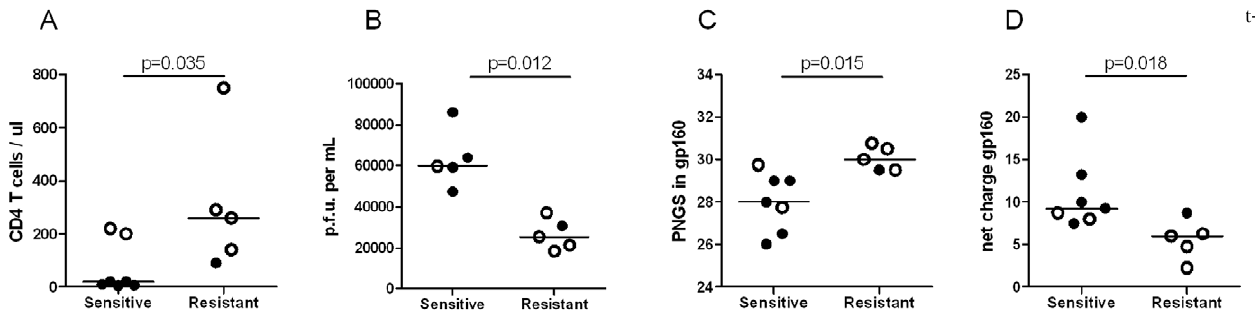
Figure 5. Patient status, viral infectivity and Env characteristics of 2G12 sensitive and resistant R5 isolates. Difference in a) CD4 + T cell count at time of virus isolation, b) viral infectivity, evaluated as plaque forming units in U87.CD4-CCR5 cells, c) gp160 PNGS numbers and d) gp160 net positive charge of R5 virus isolates being either sensitive (IC50 # 25 m g/ml) or resistant (IC50 . 25 m g/ml) to 2G12 neutralization. Presented PNGS numbers and net positive charge represent the average of four Env sequences per R5 isolates. Open circles represent chronic stage viruses, filled circles represent end-stage viruses.